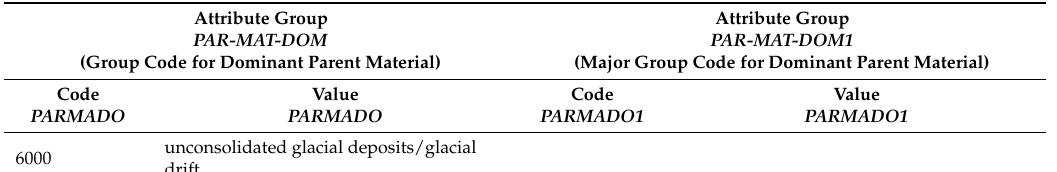
Table 3. Relationship between codes of PAR-MAT-DOM and PAR-MAT-DOM1.